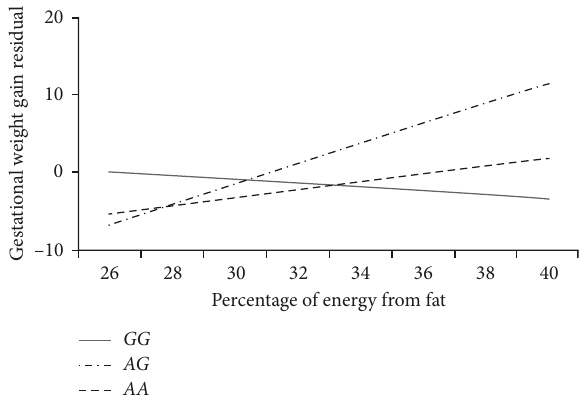
Figure 1: Interactions between rs11084753 close to KCTD15 and percentage of energy intake from fat on gestational weight gain. Gestational weight gain residual was obtained by adjusting for maternal age, smoking, marital status, prepregnancy BMI, parity, and illicit drug use. Regression lines represent the expected re- lationship between dietary fat intake and gestational weight gain for individual